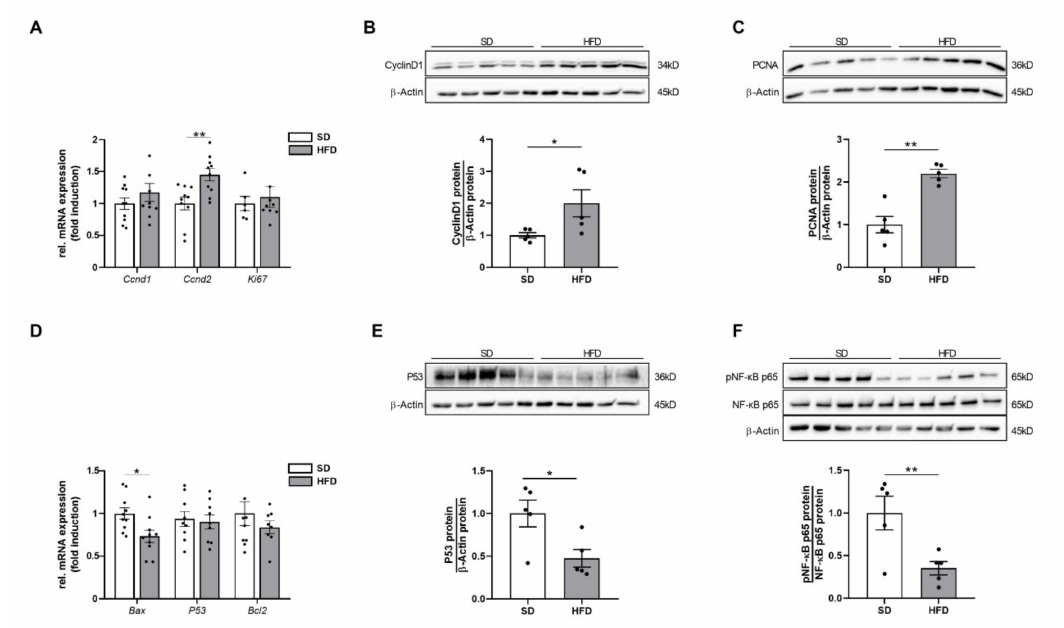
Figure 6. Hepatic growth restriction after perinatal obesity is related to increased expression of proliferative markers. ( A ) Assessment of gene expression of markers of cell proliferation and cell cycle regulation ( Ccnd1 , Ccnd2 , Ki67 ) in livers at P21 using quantitative RT-PCR. ( B,C ) Immunoblots showing protein abundance of Cyclin D1 ( B ) and PCNA ( C ) in livers at P21. ( D ) Measurement of gene expression of apoptotic markers ( Bax , P53 , Bcl2 ) using quantitative RT-PCR. ( E,F ) Assessment of P53 (E), and phosphorylated as well as total NF- κ B p65 ( F ) protein abundance in livers at P21 (n = 10 per group). Immunoblots: SD group (n = 5), HFD group (n = 5). β -Actin served as loading control. Densitometric analyses are displayed below the respective immunoblots. Data are presented as mean ± SEM; * p < 0.05, ** p < 0.01. Bax, bcl-2-associated x protein; Bcl2; B-cell lymphoma 2; Ccnd1, cyclin D1; Ccnd2; cyclin D2; HFD; high-fat diet; NF- κ B, nuclear factor kappa B; p; phosphorylated; P53, tumor protein p53; PCNA, proliferating cell nuclear antigen; SD, standard